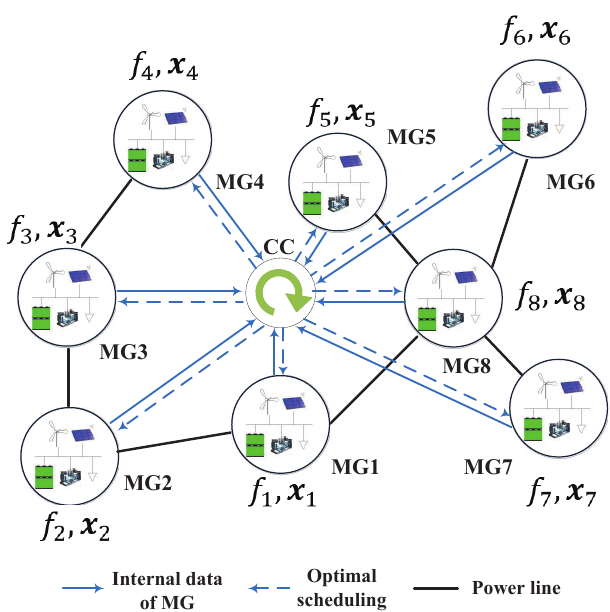
Figure 1. Centralized optimal scheduling of the interconnected microgrids